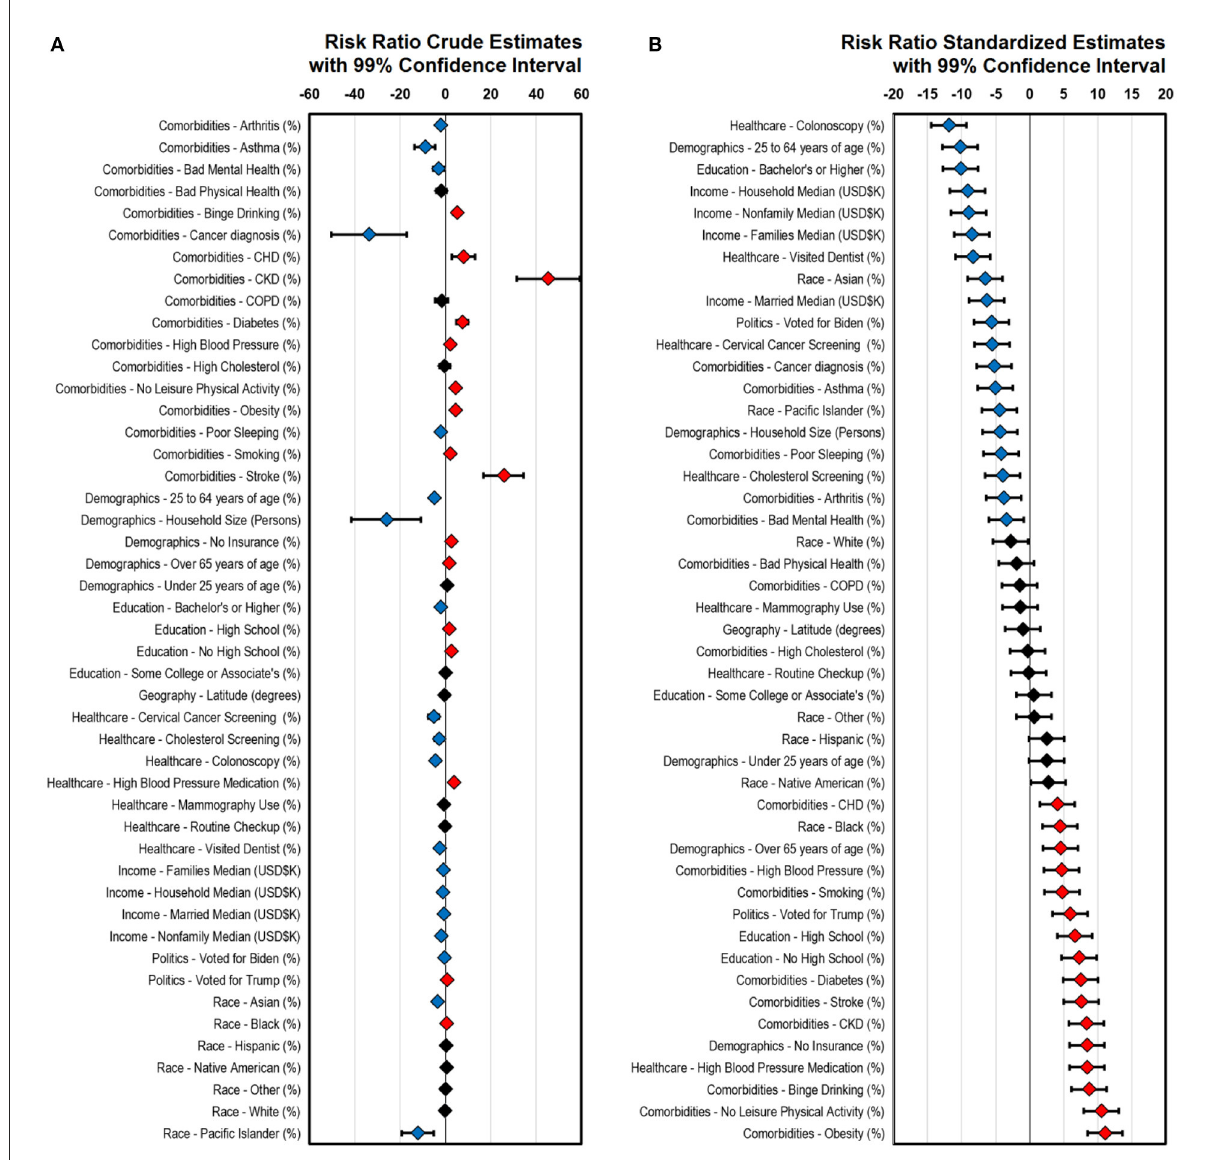
FIGURE1 Comorbidity, sociodemographic and determinants of health associations to COVID-19 case-fatalities. All models are CCVI adjusted. (A) Risk ratio crude estimates. (B) Risk ration standardized estimates (ordered). Blue diamonds indicate case-fatality reduction, red diamonds indicate case-fatality increase, and Black diamonds indicate no association. A total of 3140 counties were included in the study. Even when 99% CI are presented, association are declared significant at a Bonferroni adjusted threshold (47 tests P adj ≤ 1.06E-03). COPD, Chronic Obstructive Pulmonary Disease; CKD, Chronic Kidney Disease; CHD, Coronary Heart